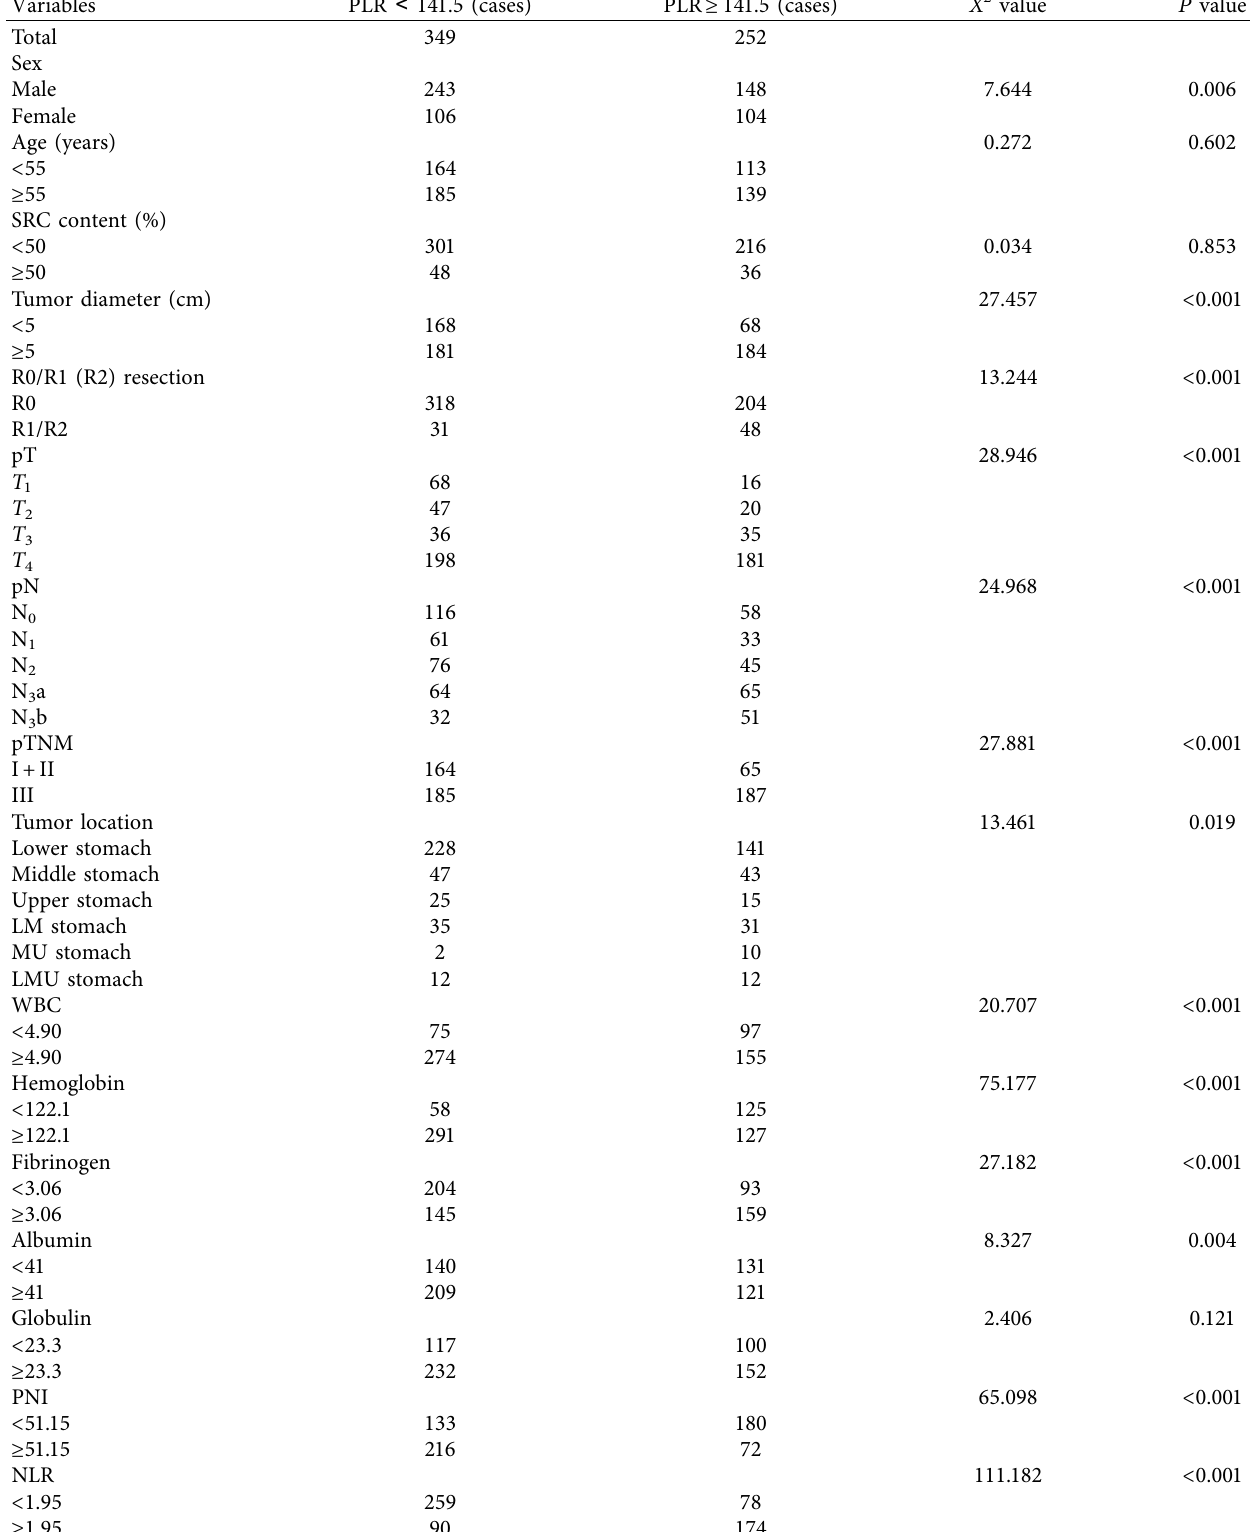
Table 2: The clinicopathological characteristics of 601 patients with gastric